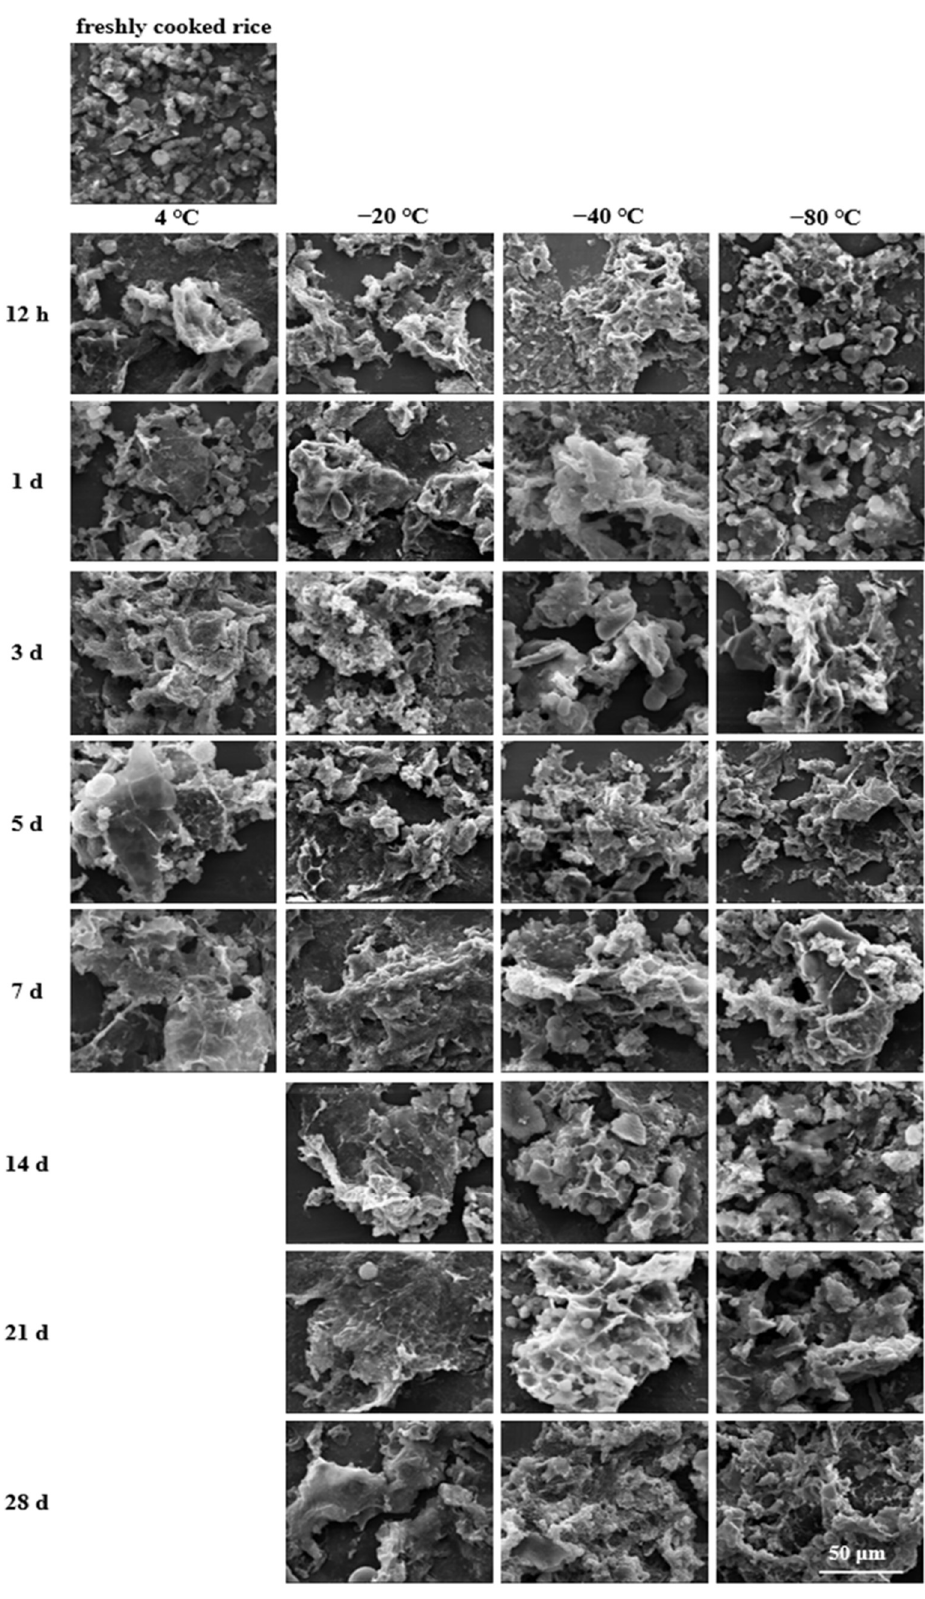
Figure 5. Microstructural changes of fresh and stored rice samples digested in simulated intestinal digestion for 20 min (2400×, bar = 50 μm).